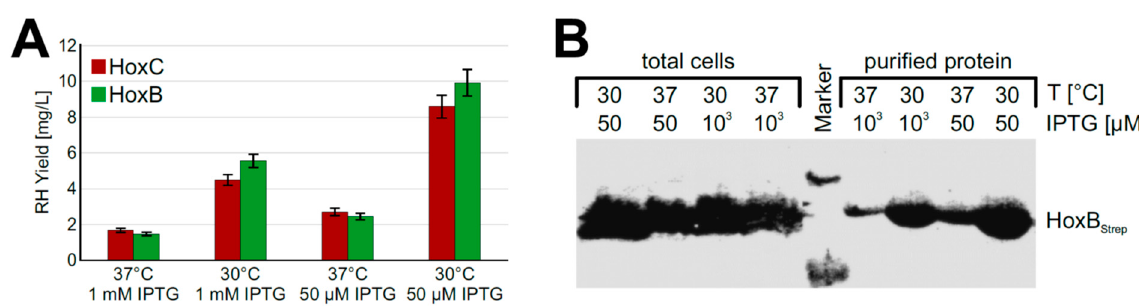
Figure 3. RH production in E. coli BQF8RH cultivated in 50 mL TB medium in UYF at 37 °C and 30 °C. RH production was induced with IPTG as indicated for 5 h. Soluble RH was purified by affinity chromatography and subsequently analyzed by SDS-PAGE and Western blotting. ( A ) Calculated amounts of purified RH after quantification of the stained gels in Figure S3 with ImageJ; ( B ) Western blot of total protein and soluble protein with antibodies against the Strep-tag at HoxB.